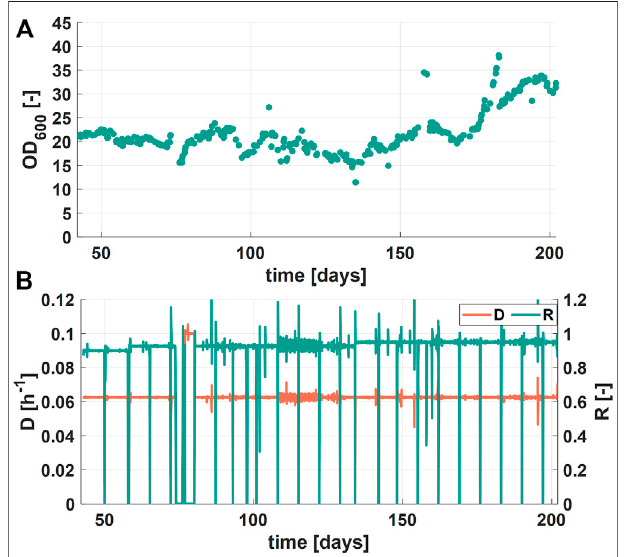
FIGURE 5 | Process performance of long-term experiment phase (days 42 – 202) (A) Optical density over the cultivation time (B) Dilution rate D (blue, lower curve) and retention rate R (orange, upper curve) over the cultivation time.